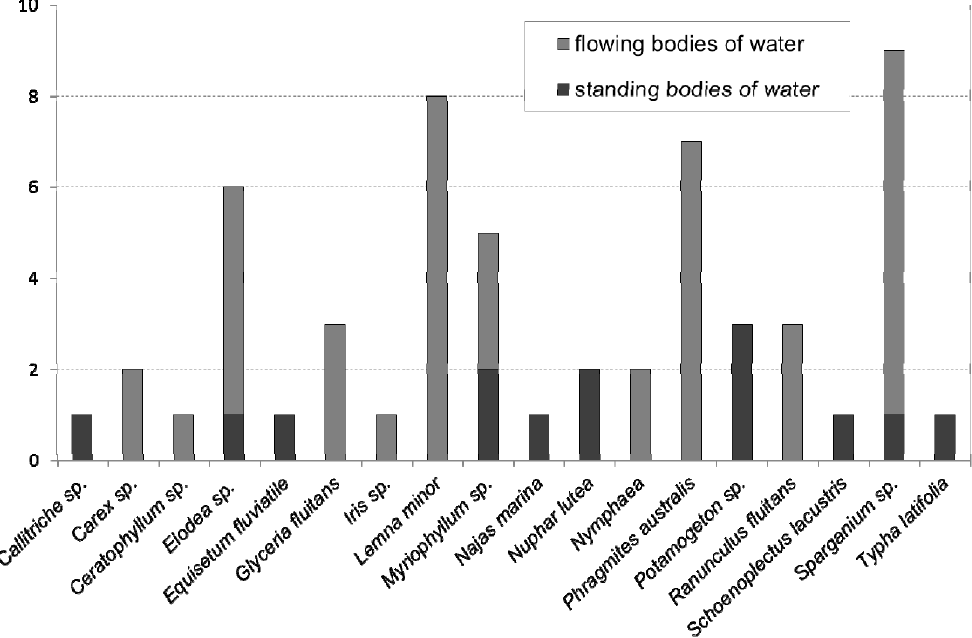
Figure 1. Number of individual plant species in the probes investigated, sorted by type of body of water (standing versus flowing).